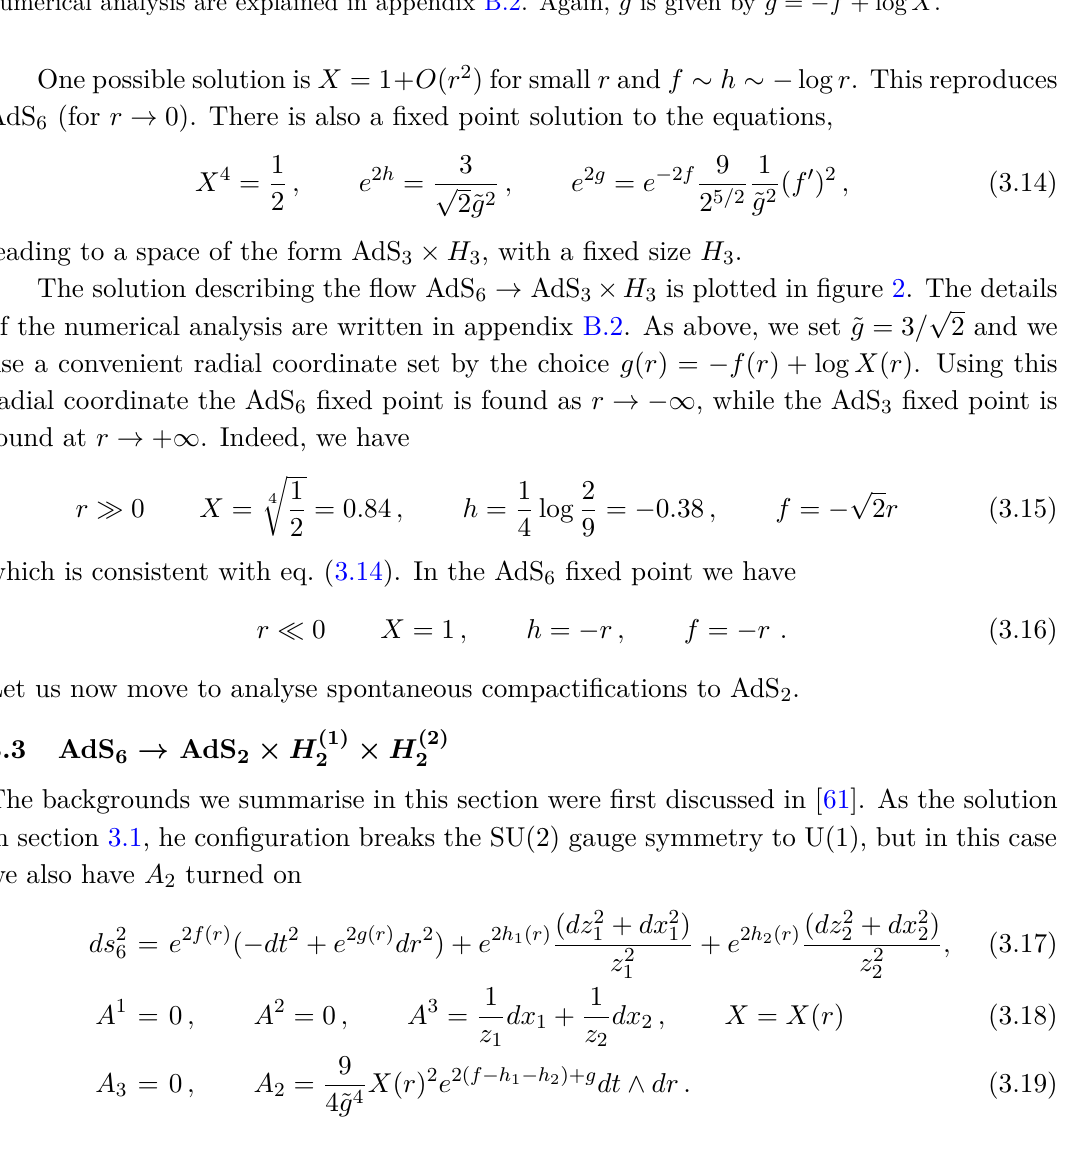
One possible solution is X = 1+ O ( r 2 ) for small r and f ∼ h ∼ − log r . This